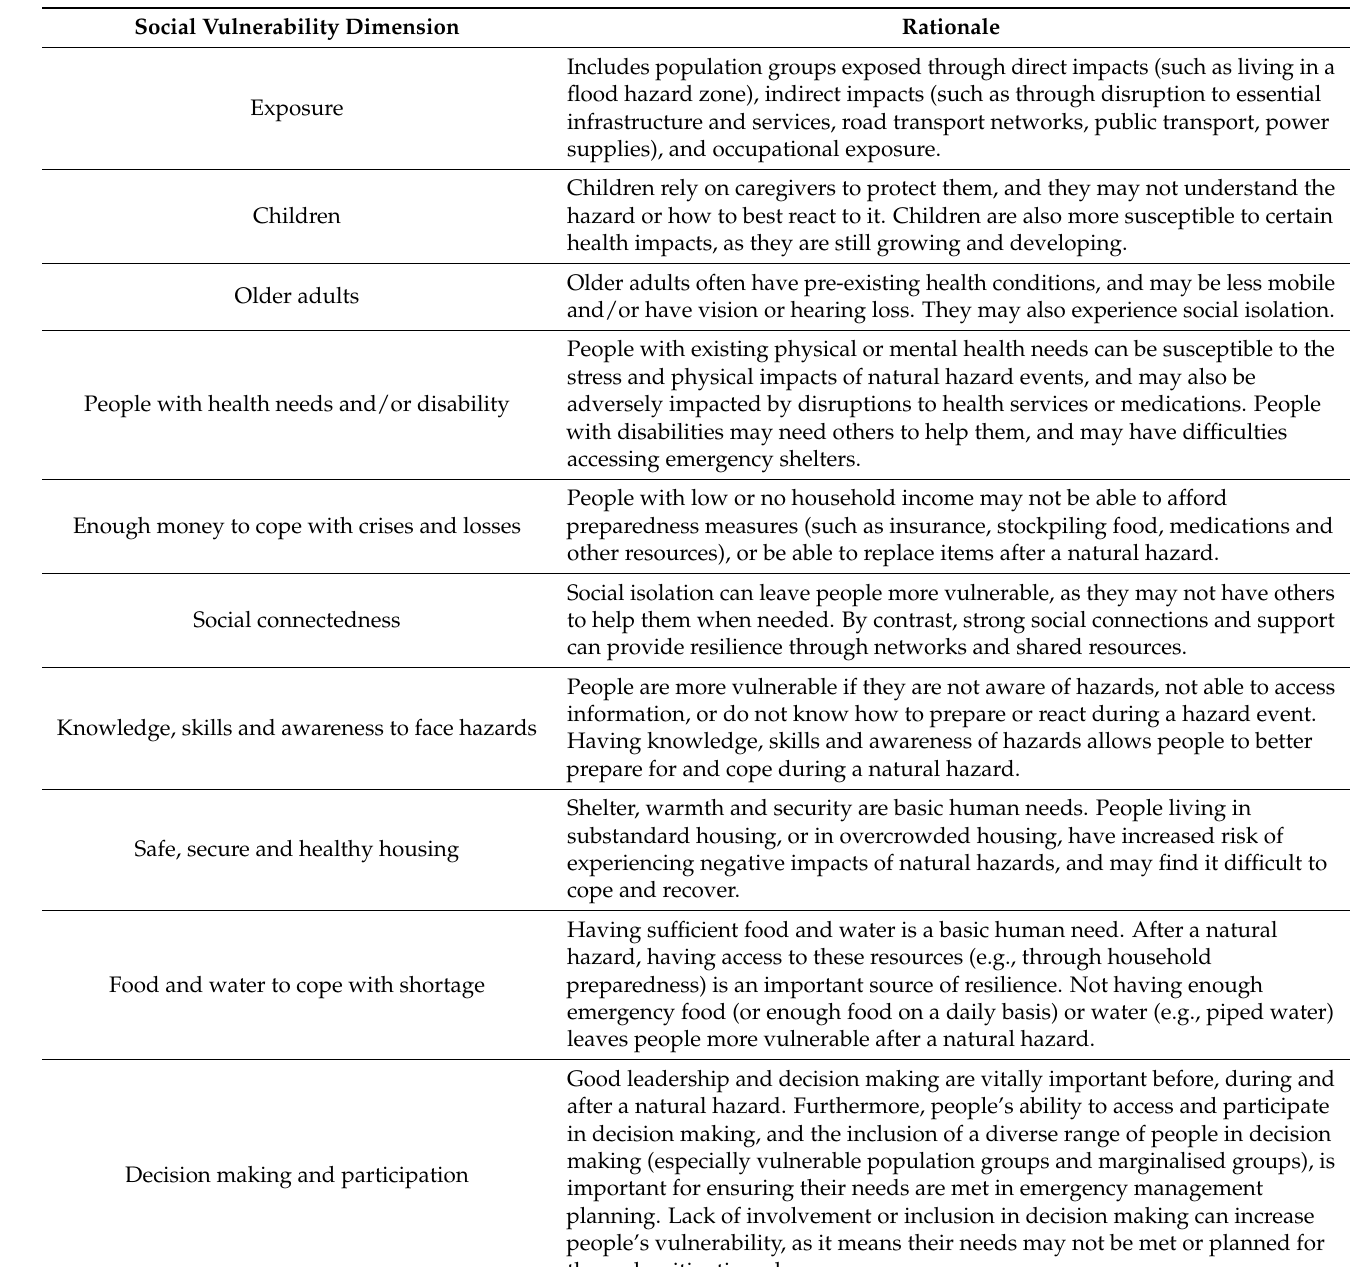
Table 2. Dimensions of social vulnerability to natural hazards, and their rationale [16,17,23–25,61,62]. Social Vulnerability